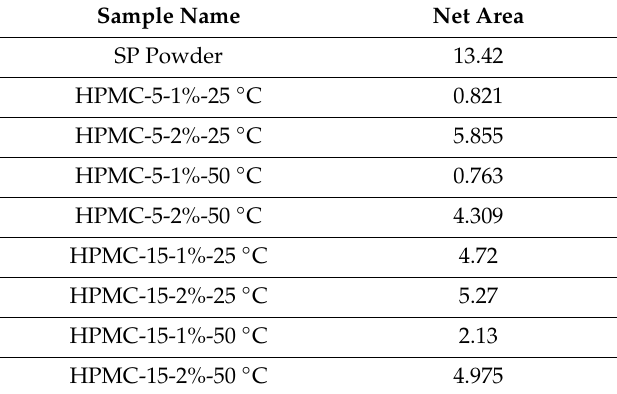
Figure 5. XRPD spectra of HPMC-5 and HPMC-15 films. ( a ) HPMC-5; ( b ) HPMC-15. Table 5. The results of the X-ray powder di ff ractometry (XRPD)